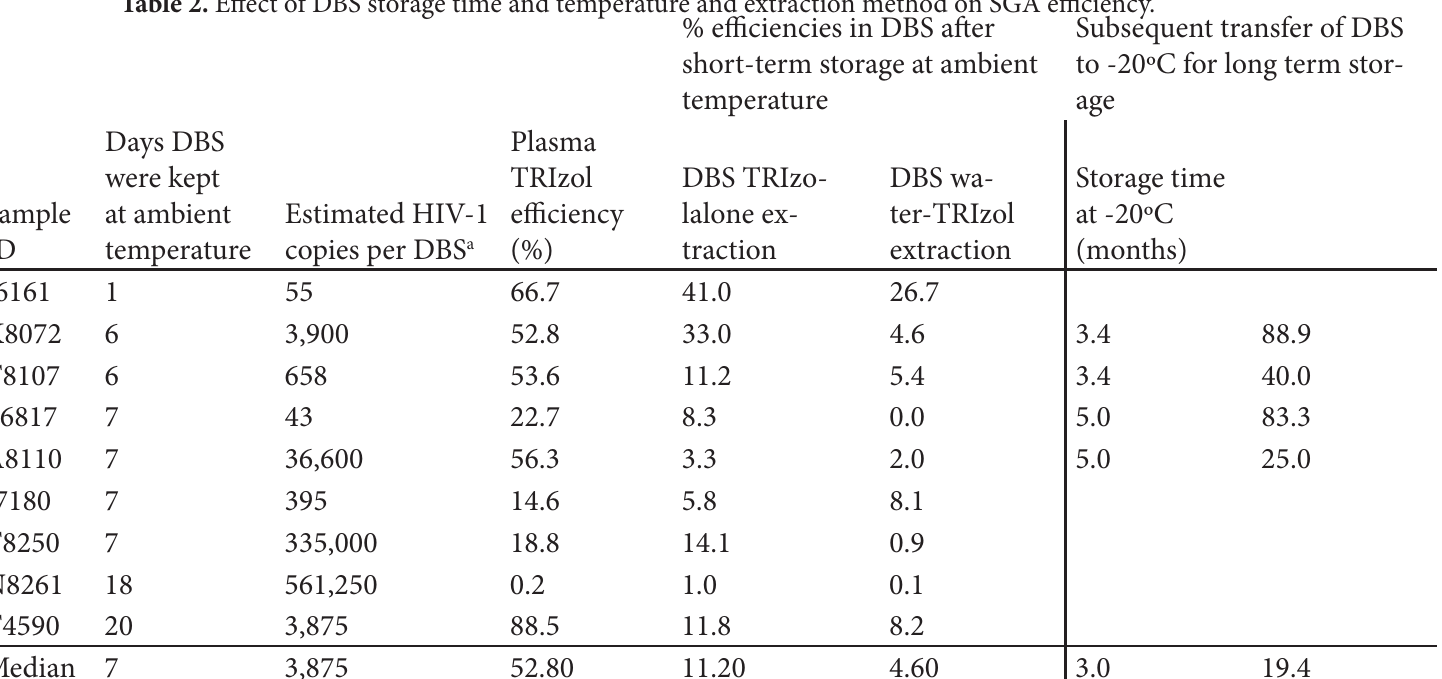
Table 2. Effect of DBS storage time and temperature and extraction method on SGA